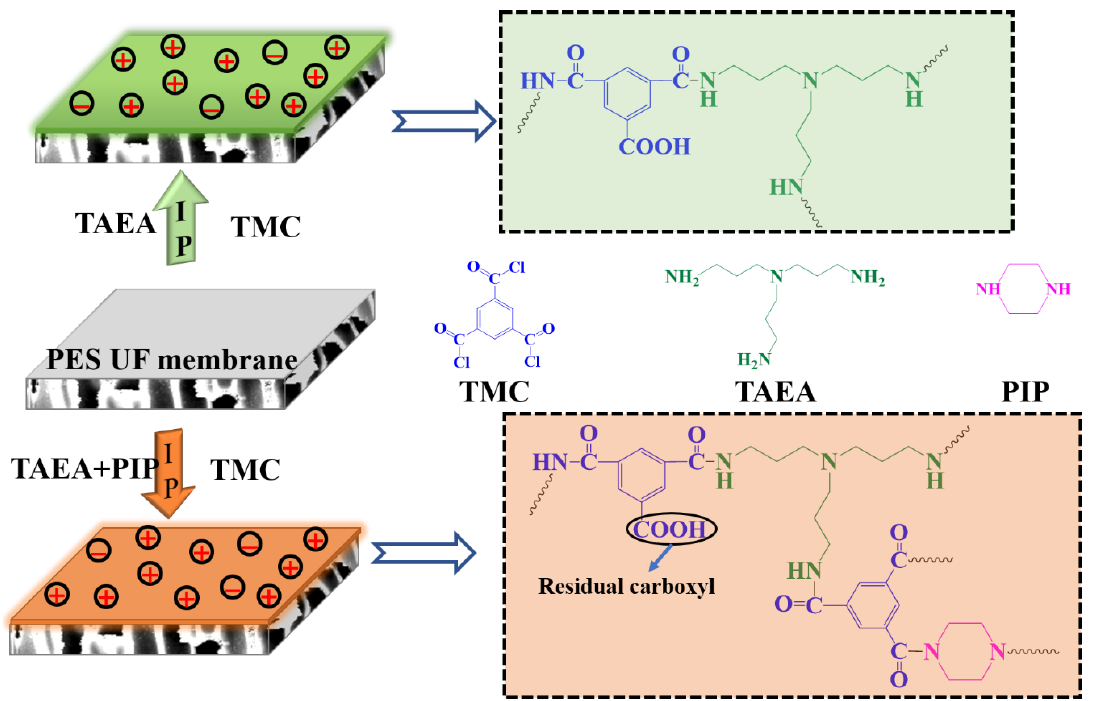
Figure 1. Schematic diagram of thin-film-composite nanofiltration (TFC NF) membranes fabrication.